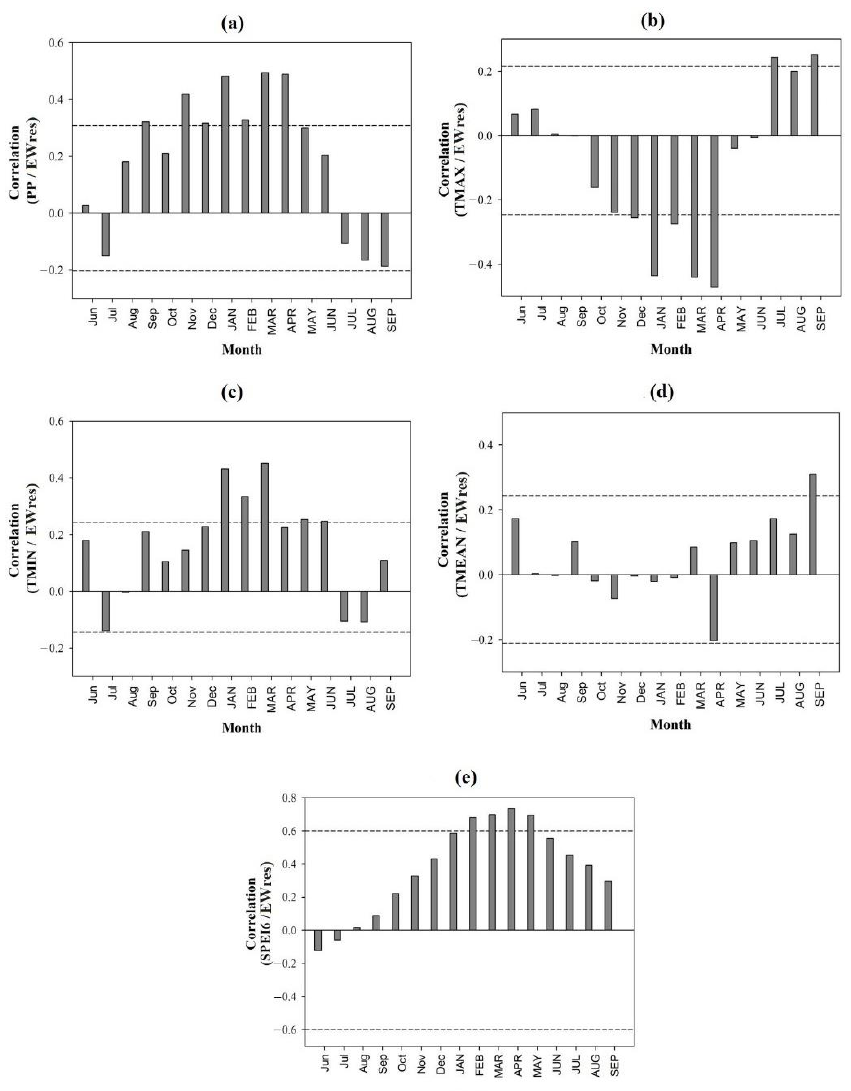
Figure 3. Correlations between the earlywood residual chronology (EWres) and the monthly cli- matic variables ( a ) precipitation, ( b ) maximum temperature, ( c ) minimum temperature, ( d ) mean temperature, and ( e ) SPEI calculated on a 6-month cumulative scale. Months in lowercase indicate the previous year, while months in uppercase correspond to the current growth year. Climate data were obtained for the period 1974–2019 (46 years). The dotted horizontal lines indicate the level of significance ( p < 0.05). For the SPEI association with the EWres the level of significance was p < 0.01. The EWres of P. durangensis showed positive responses to the SPEI, i.e., the earlywood indices increased when drought severity decreased, with the highest correlation values observed for a cumulative six-month period and from February to May (r = 0.68–0.73, p < 0.01) (Figure